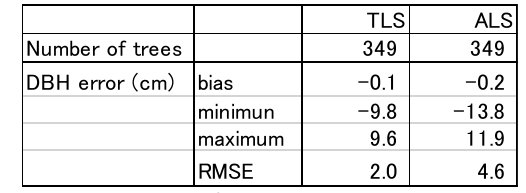
Table 3. Comparison of individual-level DBH measurements obtained by TLS and ALS